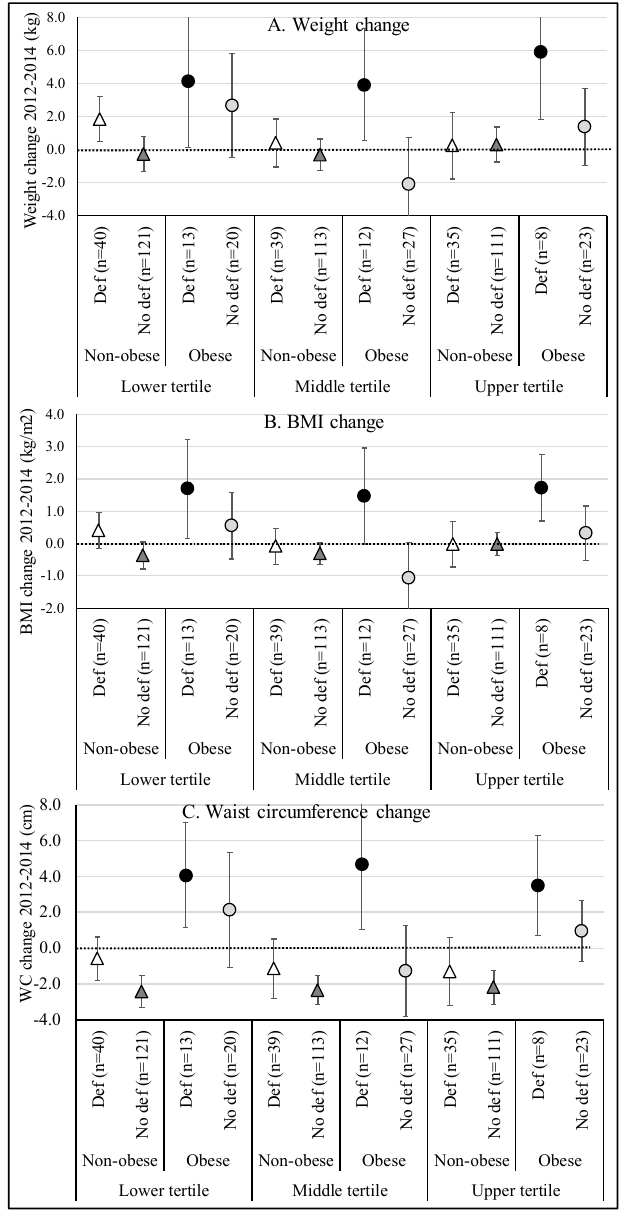
Figure 3. Adjusted a association between vitamin D intake (2012) in tertiles and change variables (weight ( A ), BMI ( B ), and WC ( C )) between 2012 and 2014, stratified by the presence of obesity (BMI ≥ 30.0 kg/m 2 ) in the baseline and the 25(OH)D serum concentration (2014). a = Adjusted for sociodemographic characteristics (sex, age, educational level, skin color, relationship status, family income per capita), vitamin supplementation, anthropometric measurement (height, weight, WC) and BMI at the beginning of the period (2012). Vertical lines represent the 95% confidence intervals. 25(OH)D deficiency = 25(OH)D serum ≤ 20 ng/mL.